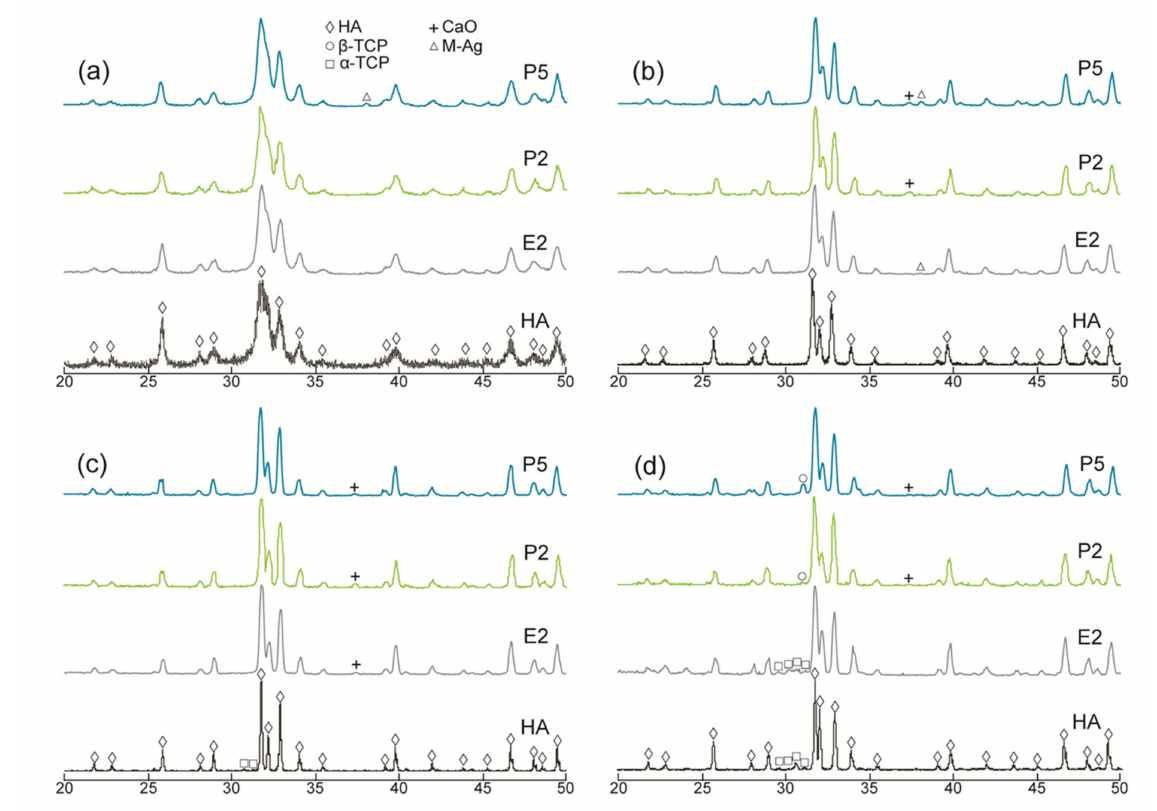
Figure 2. XRD patterns of the P-deficient AgHAs compared to E2 and pure HA heat-treated at ( a ) 700 ◦ C, ( b ) 900 ◦ C, ( c ) 1100 ◦ C, and ( d ) 1300 ◦ C. Y-axis: arbitrary